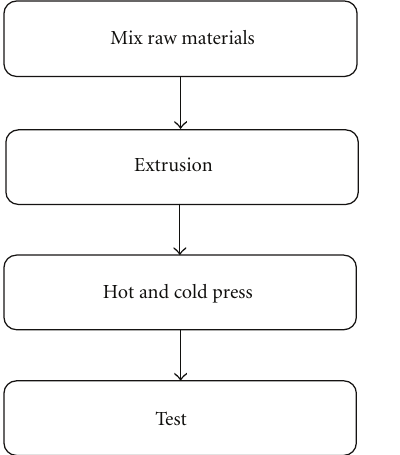
Figure 1: Flow chart of the methodology.